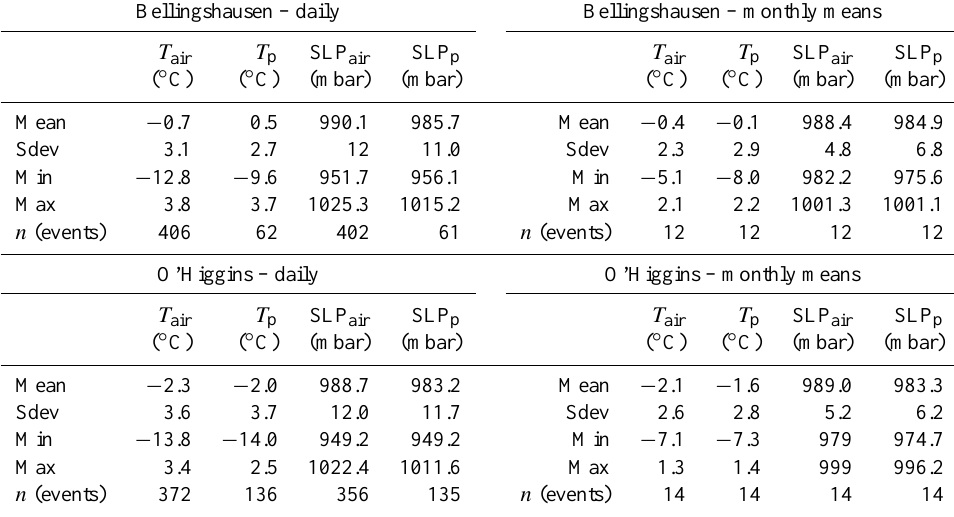
Table 3. Basic statistics of air temperature and air pressure at sea level for Bellingshausen Station at Fildes Peninsula (FP) and O’Higgins Station (OH), separately calculated for days with precipitation ( T p and SLP p ) and for the whole collection period ( T air , SLP air